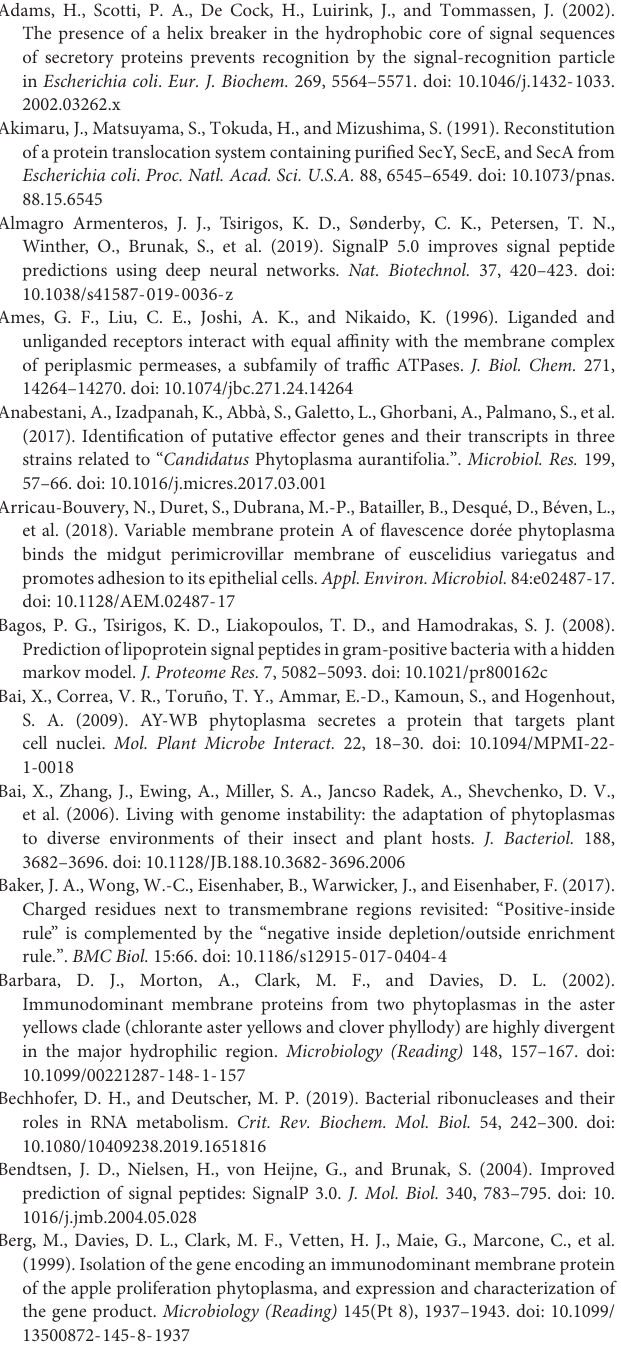
Supplementary Table 10 | List of sequences from the RNaseY family obtained by using an alternative start codon. These accessions are not part of Genbank. Supplementary Table 11 | List of Amp accessions used in this study.